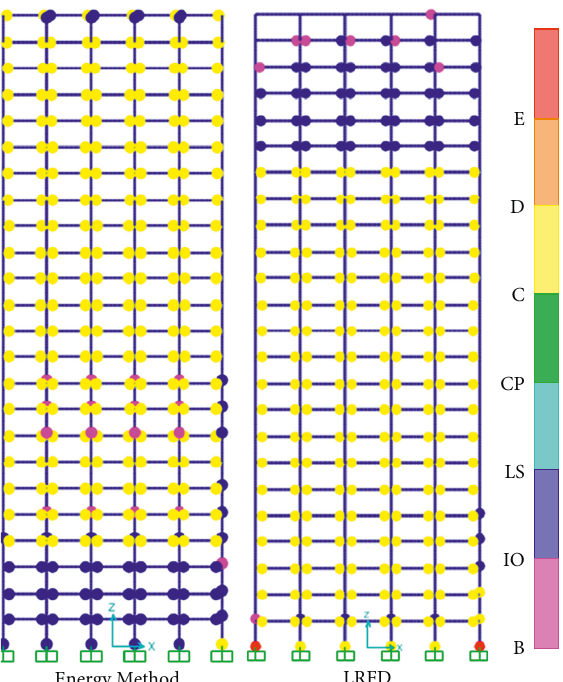
Figure 20: Plastic hinges created in the 24-story frames designed by the energy and LRFD methods.